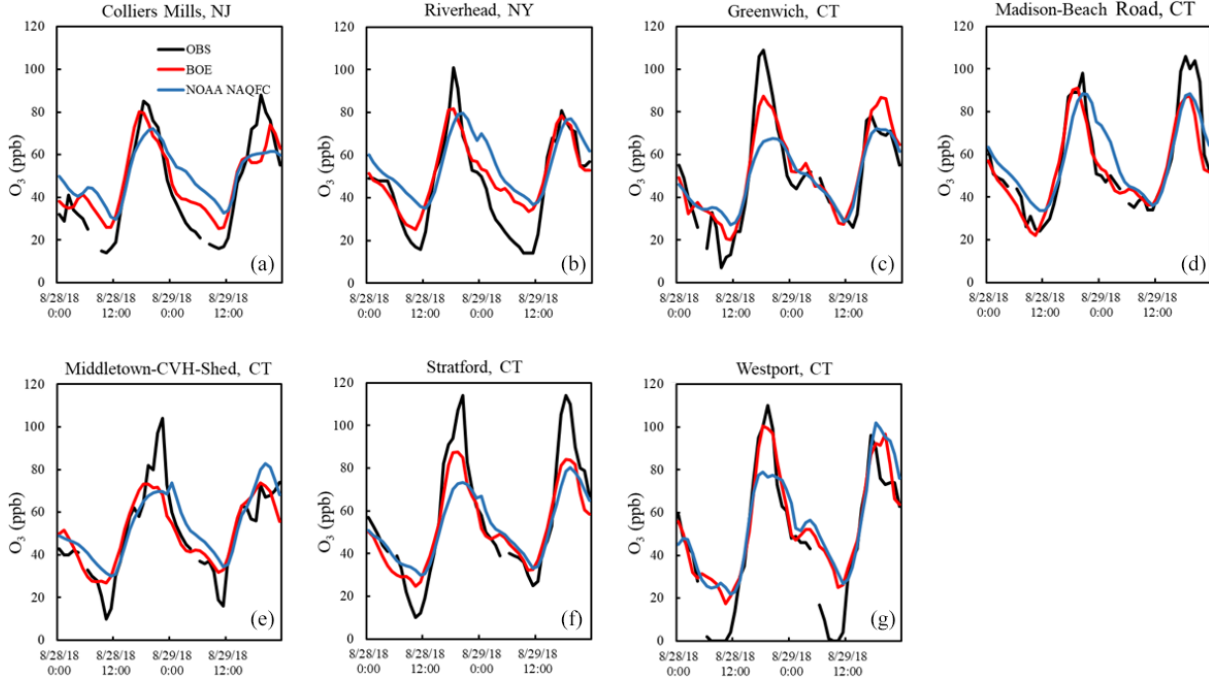
Figure 12. Time series of observed (OBS) and simulated surface O 3 concentrations by the 3km system with dynamic boundary conditions, OI initialization and emission adjustment (BOE) and the 12km NOAA National Air Quality Forecast Capability System (NAQFC) system at the seven sites where the National Ambient Air Quality Standard (NAAQS) for O 3 were exceeded during 28–29 August 2018: (a) Colliers Mills, (b) Riverhead, (c) Greenwich, (d) Madison-Beach Road, (e) Middletown-CVH-Shed, (f) Stratford and (g)